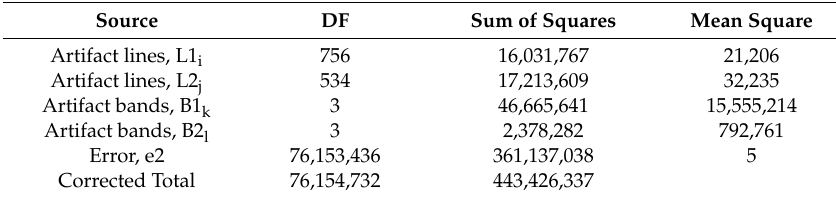
Table 2. Results of the analyses of variance (ANOVA) for removing artifact lines and bands of the SRTM C-band DEM (m) (Equation (6)). The model had an R 2 of 19%. Source DF Sum of Squares Mean Square Artifact lines, L1 i 756 16,031,767 21,206 Artifact lines, L2 j 534 17,213,609 32,235 Artifact bands, B1 k 3 46,665,641 15,555,214 Artifact bands, B2 l 3 2,378,282